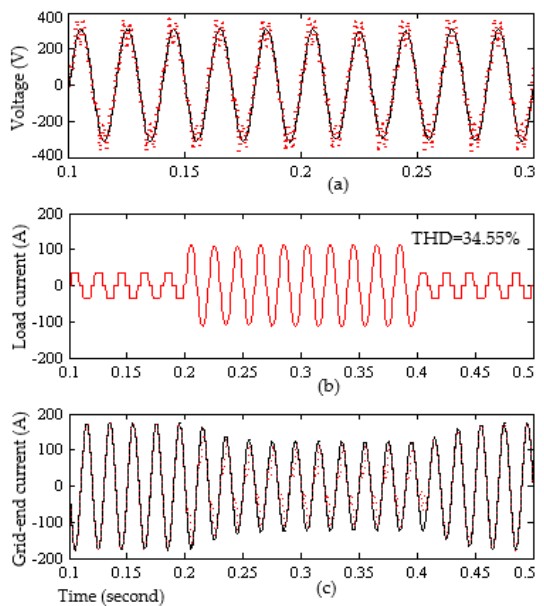
Figure 15. ( a ) Power grid and load voltages ( V ); ( b ) the load-terminal current ( A ) (phase a) (THD = 34.55%); and ( c ) power grid-end currents ( A ), compensated for by the proposed SRF method (THD = 1.29%) and compensated for by the SRF method [29].